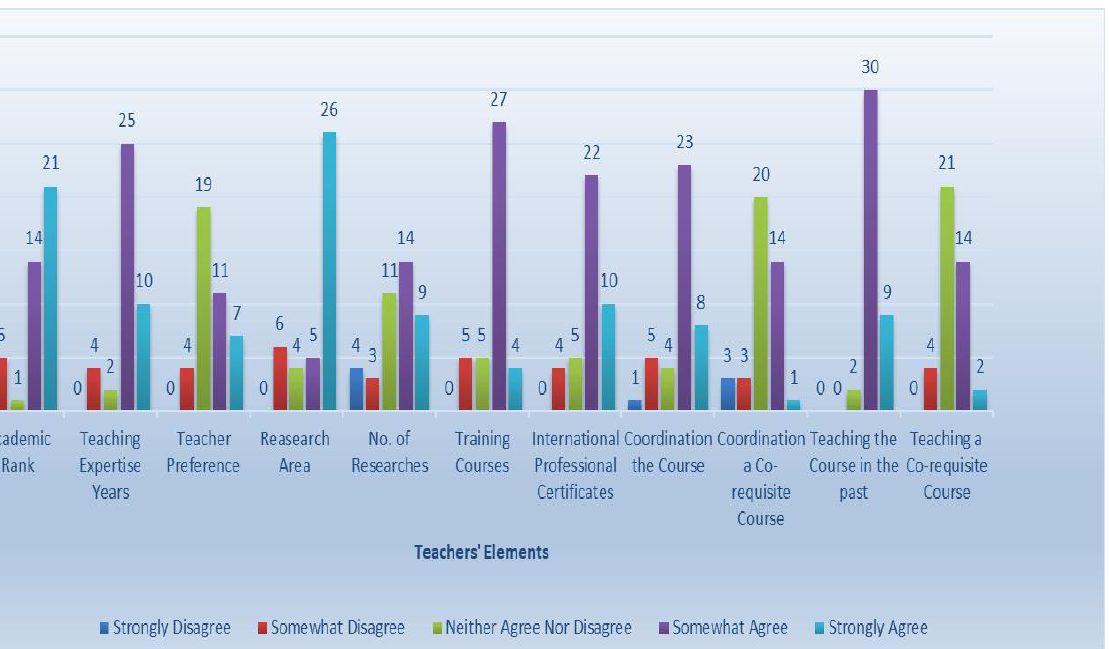
Figure 11. Comparing students ’ feedback elements. 5.2. Resulting Linked Data To judge the success of using the link data technique in improving educational deci- sions, KAULD is tested using federated queries to select all the academic teachers who can teach courses from the same department. The selection relies on the factors from the survey result mentioned in Section 5.1 and the elements extracted from MAKG, as shown in Figure 12. 3